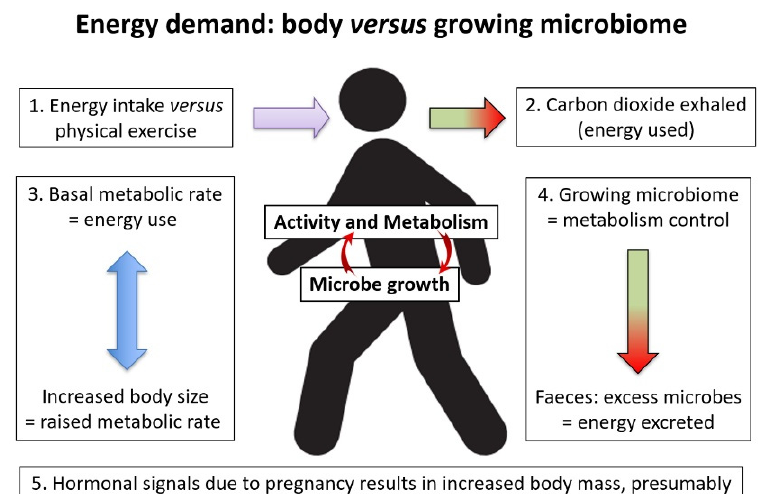
Figure 1. Activity and metabolism v. microbiome growth [50,51]. Box 1: Long term average food intake and exercise levels in the healthy adult. Box 2: Output of carbon dioxide reflecting both basal metabolic rate and exercise levels. Box 3: Indicates the relationship between body size and basal metabolic rate. In the presence of a functioning microbiome, eventual size is under genetic control. In its absence, growth will occur until basal metabolic processes balance the reduction in faecal energy output (see Box 5). Box 4: Good health requires a degree of microbial growth (Figure 2) and this leads to eventual energy loss by excretion of faeces, dependant on the health of the microbiome. Box 5: The bodily changes due to pregnancy illustrate the fine control of the allomone/hormone balance exerted through the gut–brain axis (Figure 2). In the absence of extra food or decreased physical exercise the extra energy required can come from a temporary reduction in microbial growth, presumably leading to a corresponding fall in the energy output from excretion. Famine will produce a similar outcome, in which microbial growth will be temporarily placed on hold in order to protect the host, without which the microbiome cannot survive. Feasting in the presence of a functioning microbiome may lead to an increase in faecal energy excretion, morbid obesity being unlikely if not impossible. By contrast, a disabled microbiome cannot compensate for any increased food intake, potentially leading eventually to all the consequences of unrestricted fat accumulation.